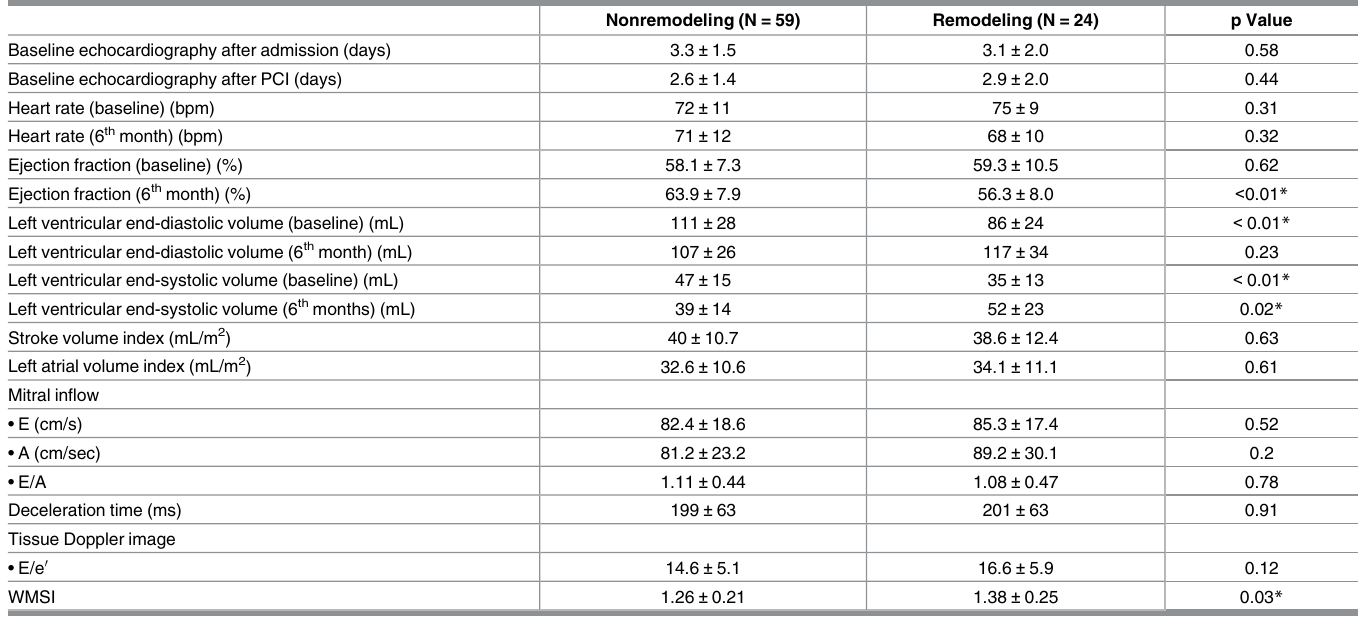
Table 2. Echocardiography